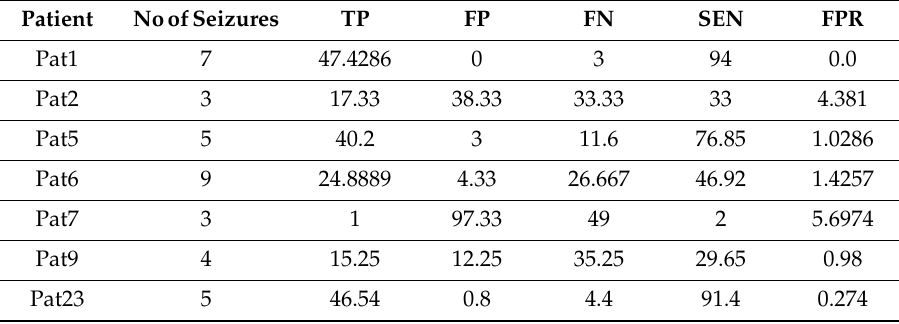
Table 6. Simulation